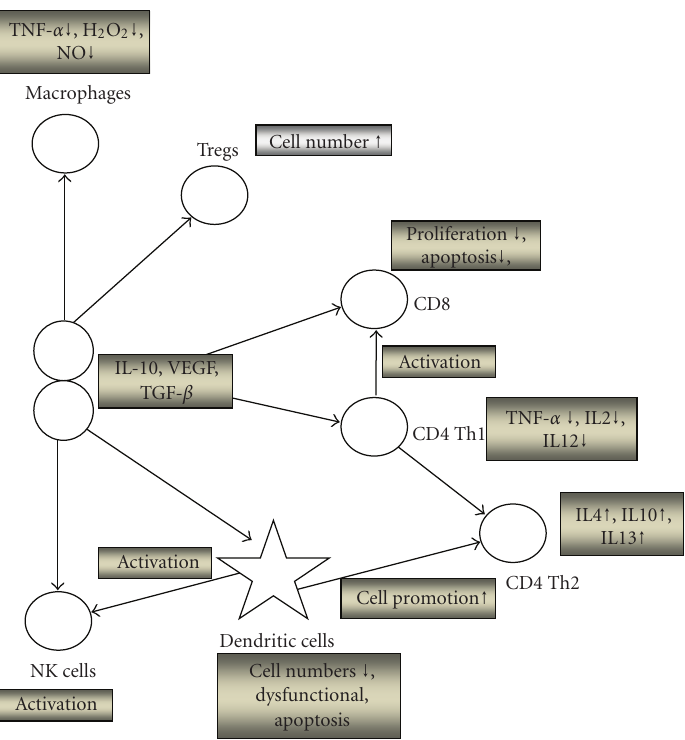
Figure 2: Schematic representation of characteristic immune cells, growth factors, and cytokines interactions in cancer. Interactions between growth factors such as VEGF, cytokines (e.g., TNF α ) and T cells (e.g., NK, Tregs) are shown in this diagram. Tumor cells bring about the production of cytokines that assist in the mobilization of T cells and induce the production of further cytokines, and they also utilize growth factors such as VEGF to promote neovasculirisation implicated in metastasis. ↑ means increase where ↓ means